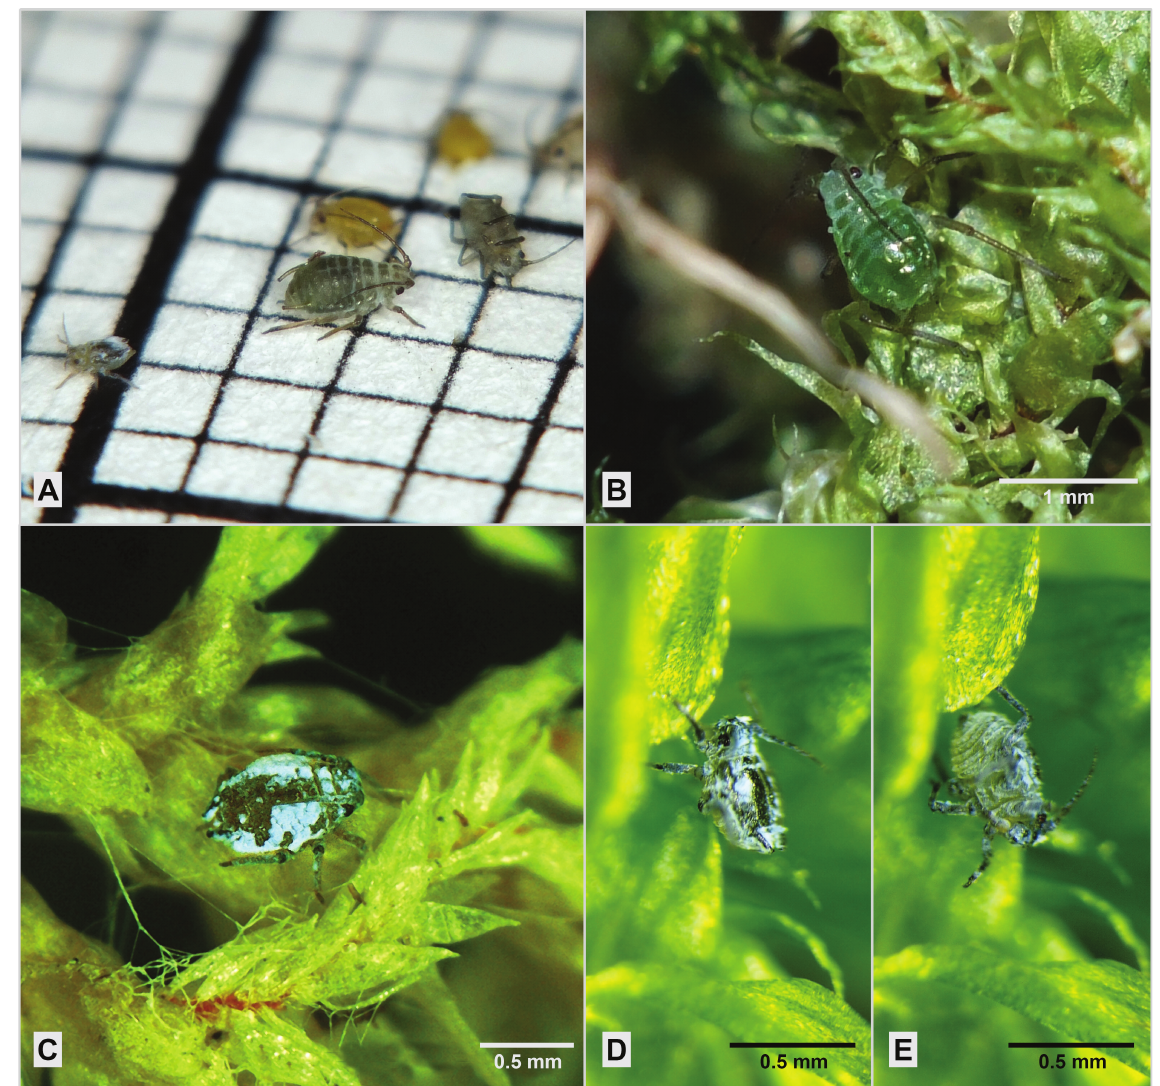
Fig. 9. Pseudacaudella rubida (börner, 1939). A . Apt. and juv. from Hylocomium splendens sample (grid 1 mm). B . Apt. and C . hibernating juv. on Pleurozium schreberi . D–E . hibernating juv on Calliergon cordifolium